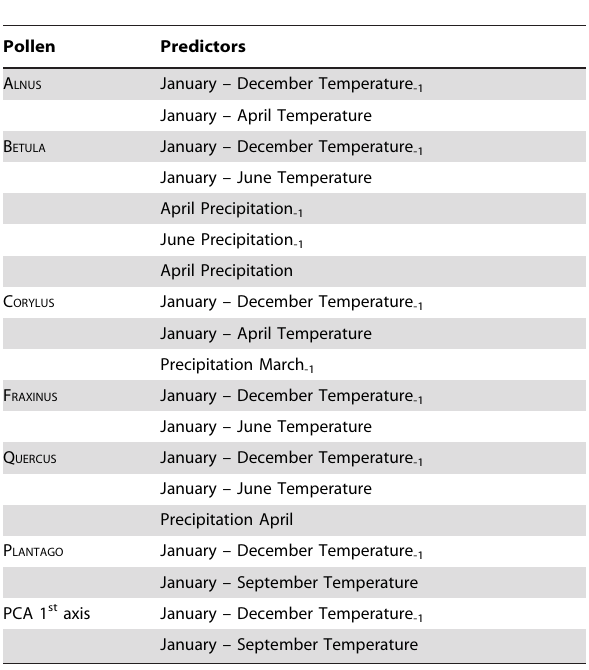
Table 3. Initial model parameters for multiple regression analysis using backward